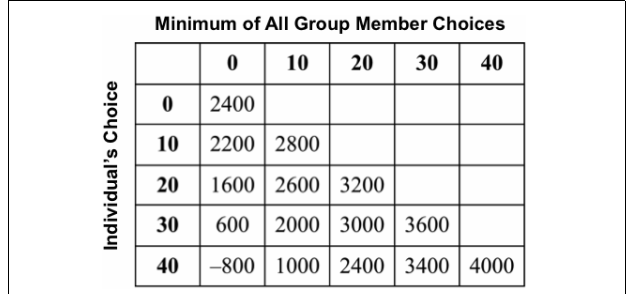
FIGURE 1 | The payoff matrix of the minimum effort tacit coordination game.